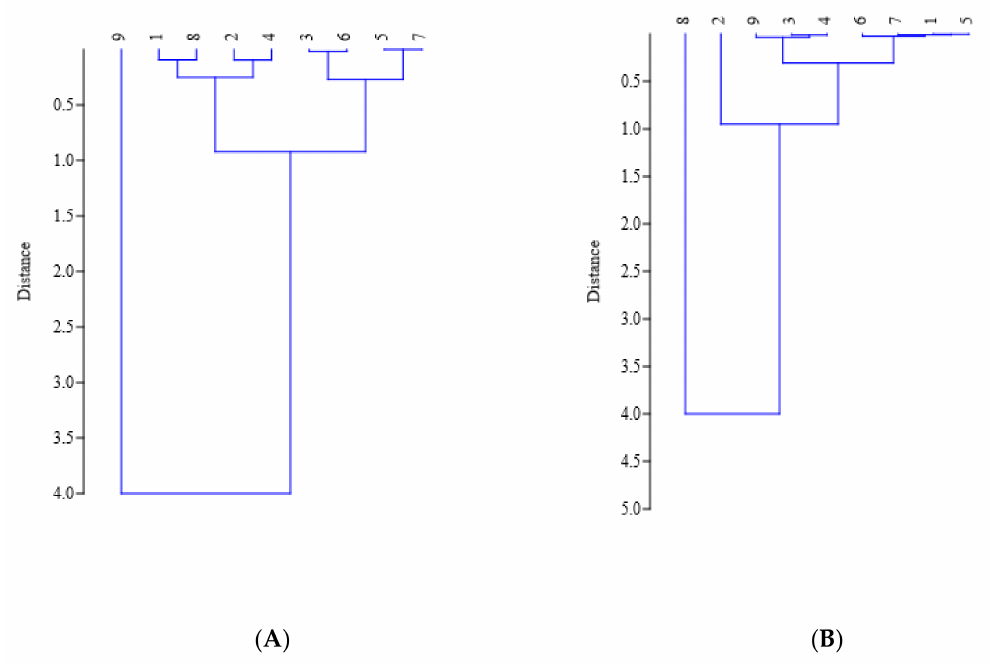
Figure 3. Cluster analysis in water ( A ) Dendrogram plot for water and sediment ( B ) Dendrogram plot for sediment.